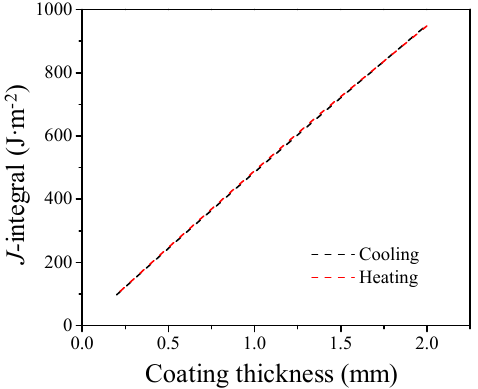
Figure 7. J i values as a function of the pure epoxy coating thickness.